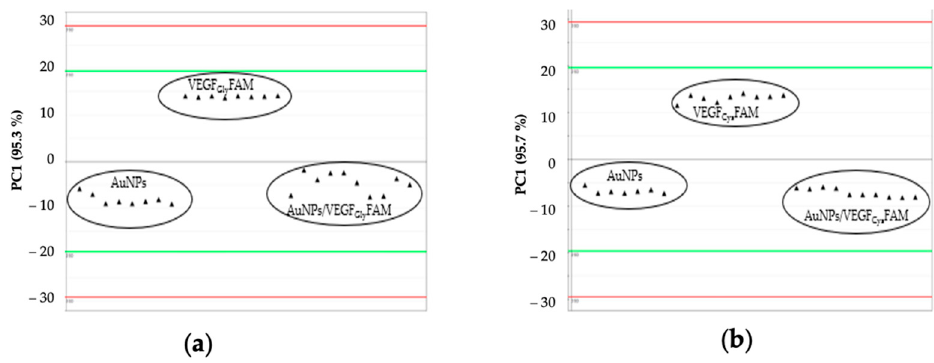
Figure 8. PC1 score plot obtained from PCA analysis of positive ToF-SIMS spectra (at least five spectra for each sample) of functionalized AuNPs with VEGF Gly FAM ( a ) and VEGF Cys FAM ( b ) pep- tides.